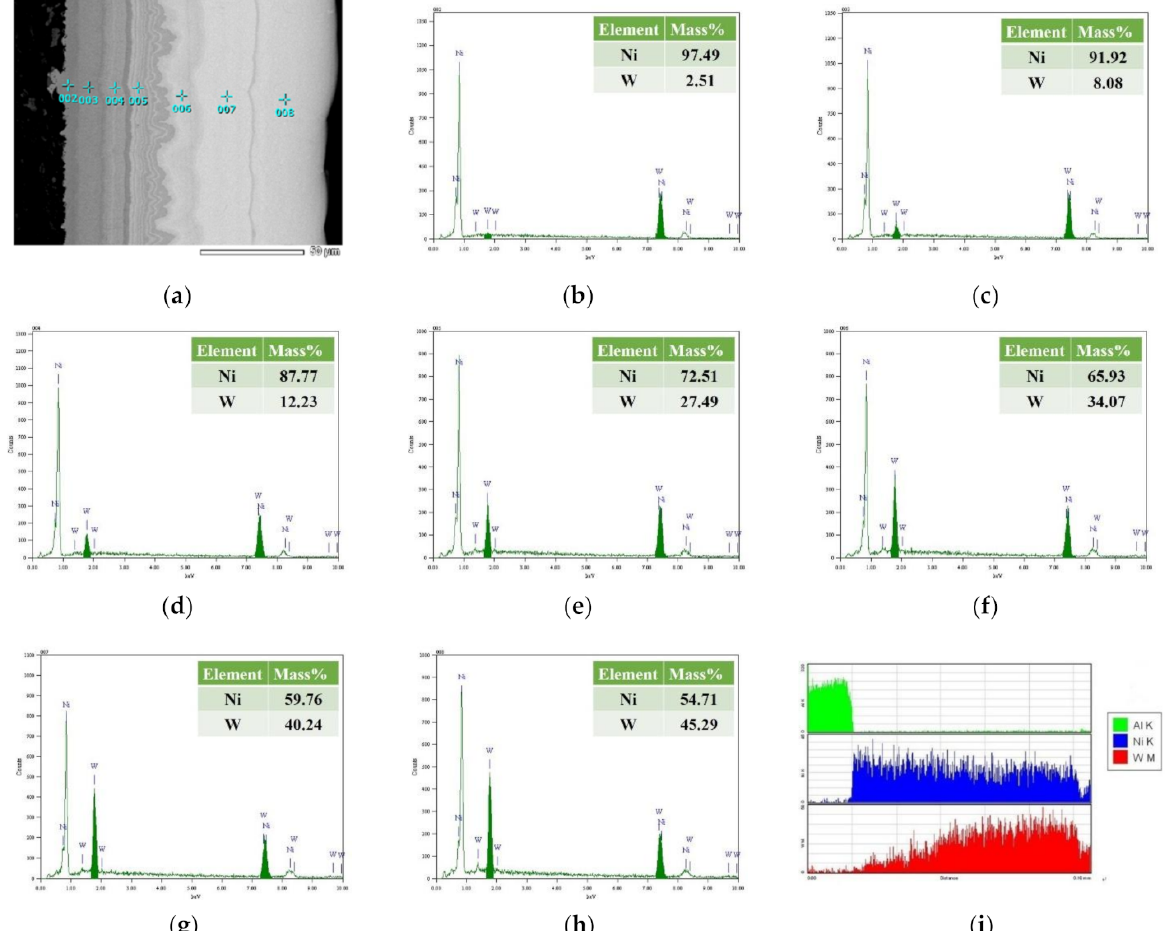
Figure 8. The EDS spectra of Ni–W graded coating: ( a ) the SEM of Ni–W graded coating, ( b – h ) the EDS spot spectra of different layers from first layer to seventh layer, ( i ) the EDS line spectra of Ni–W graded